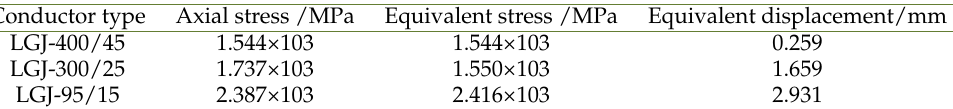
Table 5. Comparison of mechanical changes of different conductors